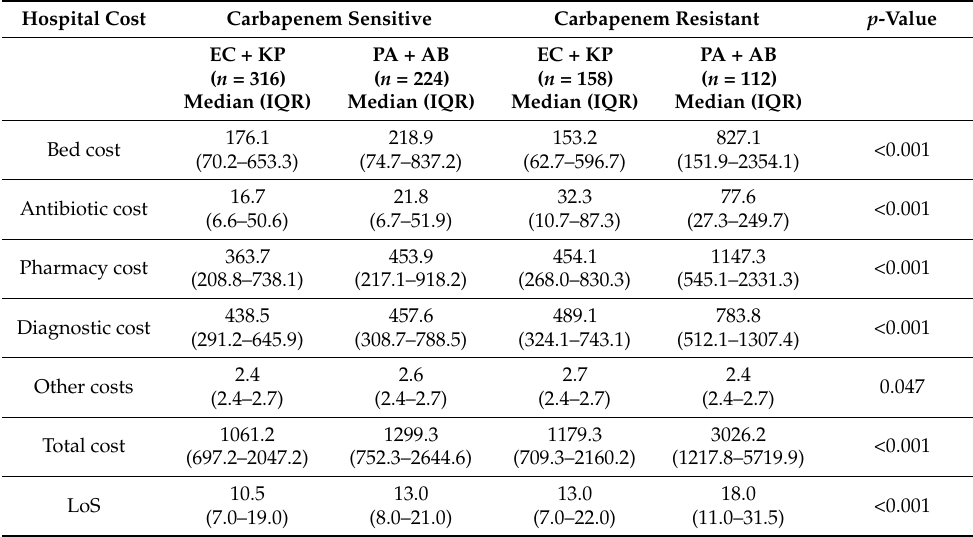
Table 4. Costs and length of stay for various components among four groups by carbapenem status and organism type (in 2021